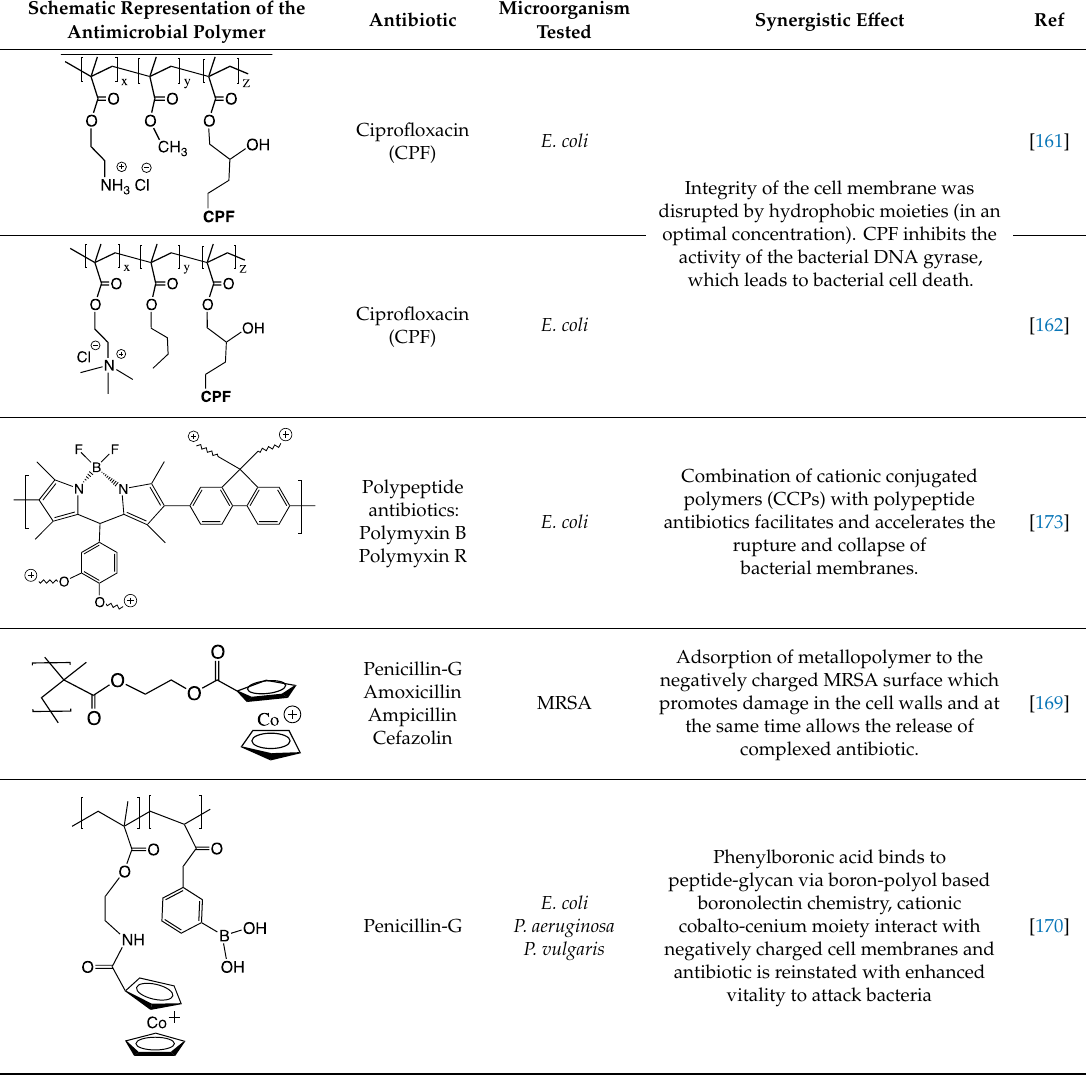
Table 4. Selected antimicrobial systems based in cationic polymers and antibiotics. Schematic Representation of the Antimicrobial Polymer